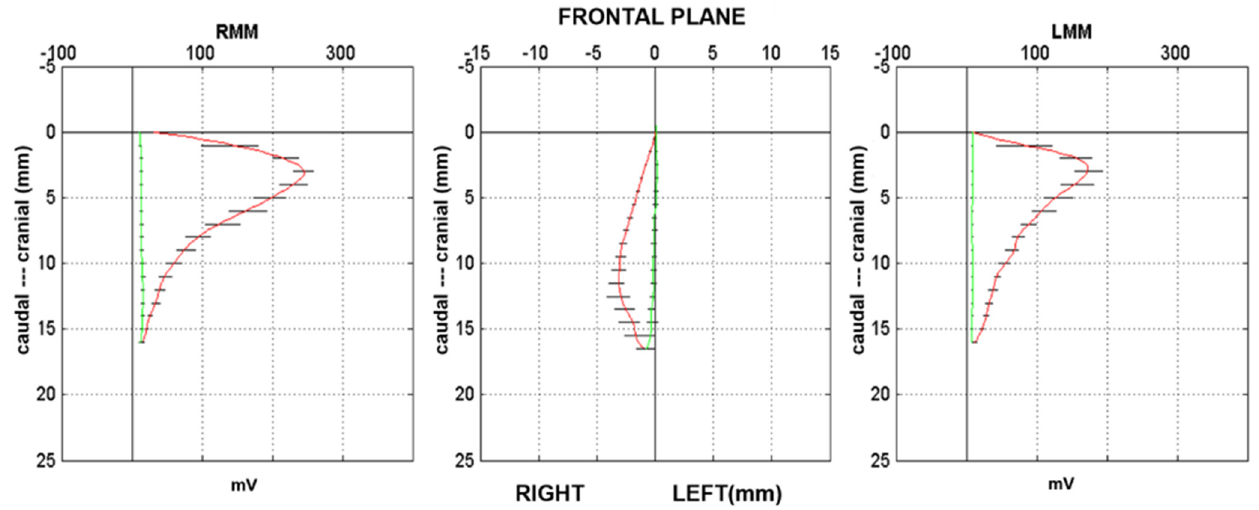
Figure 2. The masticatory kinematic pattern in the frontal plane (central plot), and the EMG envelope of the right and left masseter, plotted versus the vertical jaw displacement of a patient with deep bite malocclusion, during chewing of a hard bolus on the right side. The solid line, green for the opening pattern and red for the closing pattern, represents the average chewing cycle of 3 trials, lasting 10 s each; the black lines represent the standard deviation over the average cycle. Top: image of the deep bite malocclusion of one of the patients. Note the very high activity and the narrow pattern with very low standard deviation, especially in the occlusal phase of the closing pattern, indicating that the dental malocclusion and the hyperactivation of the masseter muscles restrict the mandibular movements. This is a functional malocclusion; the teeth position is the consequence of the cranial and muscular structure. mV, millivolt; RMM, right masseter muscle; LMM, left masseter muscle.